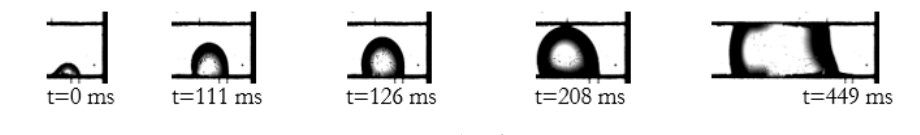
Figure 11. Slug formation.